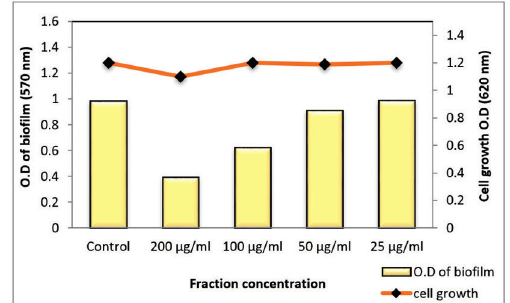
Fig. 9. Effect of sub-MICs of Z. spina-christi total extract on biofilm formation on MRSA strain